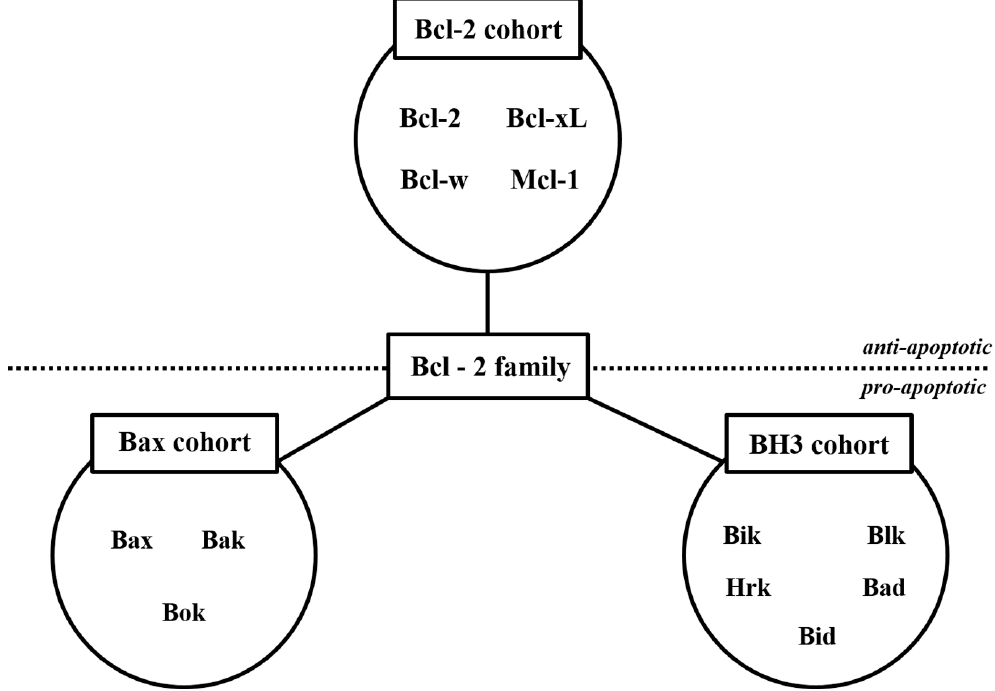
Figure 2. The Bcl-2 family proteins. The Bcl-2 family proteins play crucial roles in the apoptosis process. The upper side shows antiapoptotic factors, while the lower side shows proapoptotic factors.